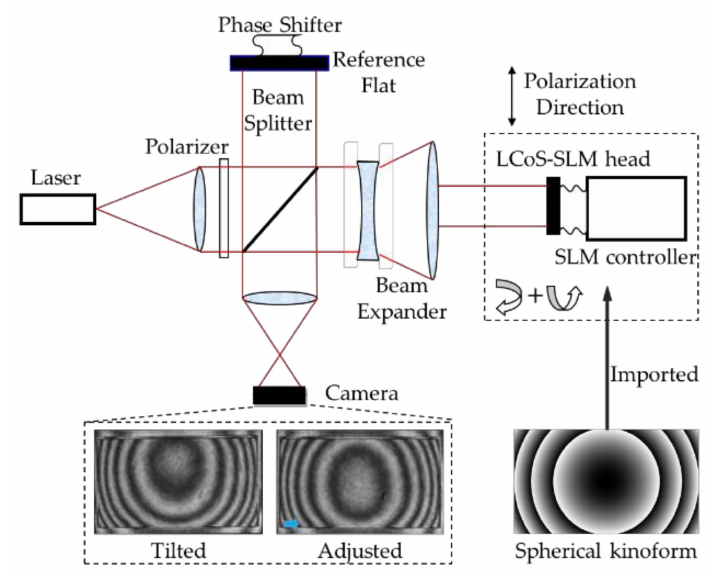
Figure 5. Optical setup and the adjustment